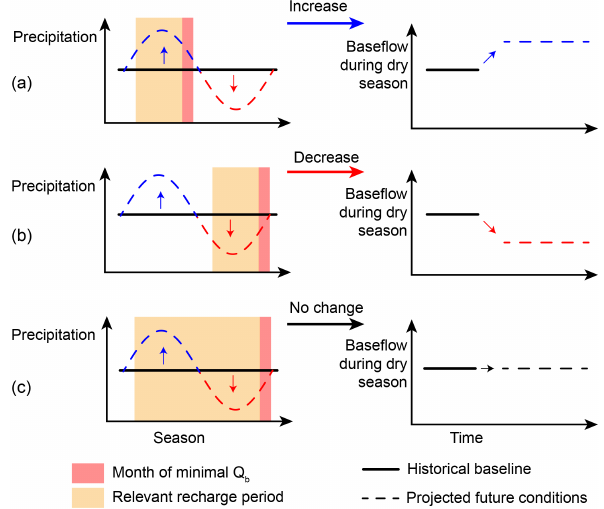
Figure 3. Potential directional changes in Q b7 under a constant sea- sonally diverging precipitation change scenario, depending on T R and M Q : (a) increase, (b) decrease and (c) no change. b7